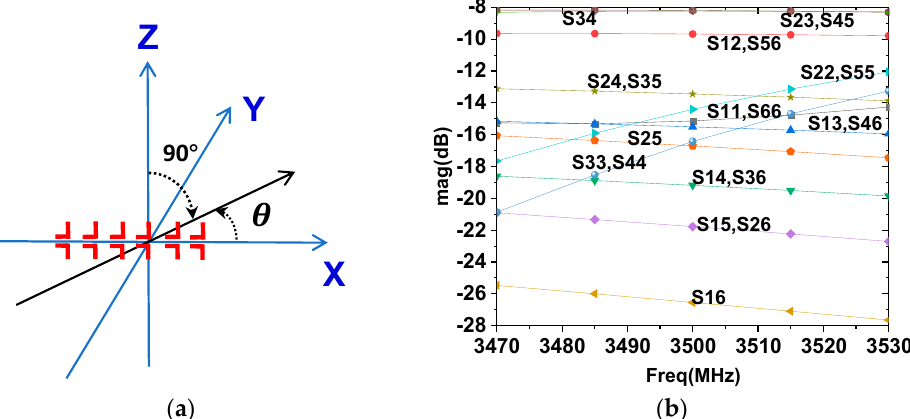
Figure 1. ( a ) 6-port ULA of V-pol half-wave dipoles. ( b ) The magnitude of all the EM-exact S-parameters of a 6-port ULA of dipoles used in the present work.